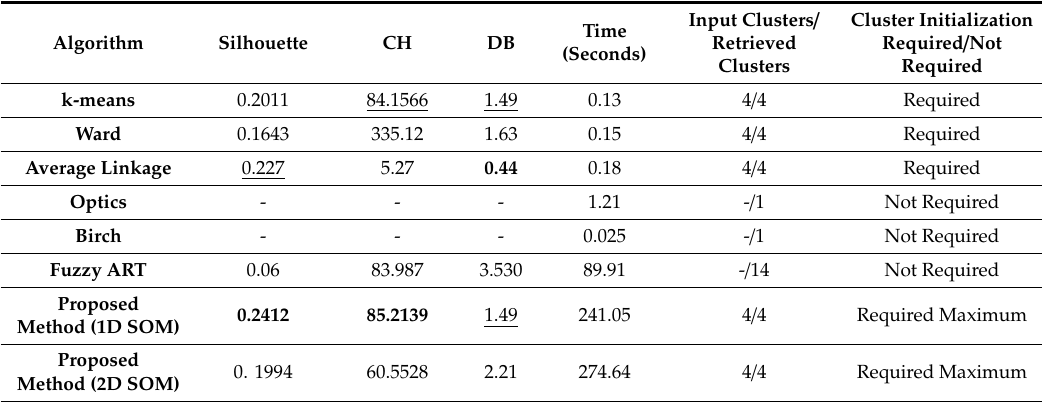
Table 2. The comparison of the proposed technique with state-of-the-art clustering algorithms over the individual household electric power consumption